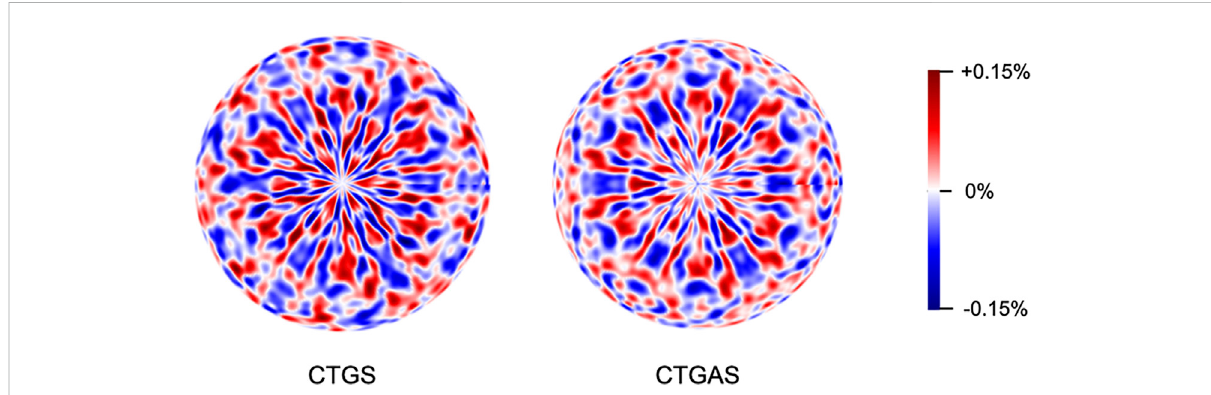
FIGURE 4 Ta-L α X-ray fl uorescence holograms of CTGS and CTGAS crystals, which were measured at 100 K under irradiation with X-rays of 11.0 keV.